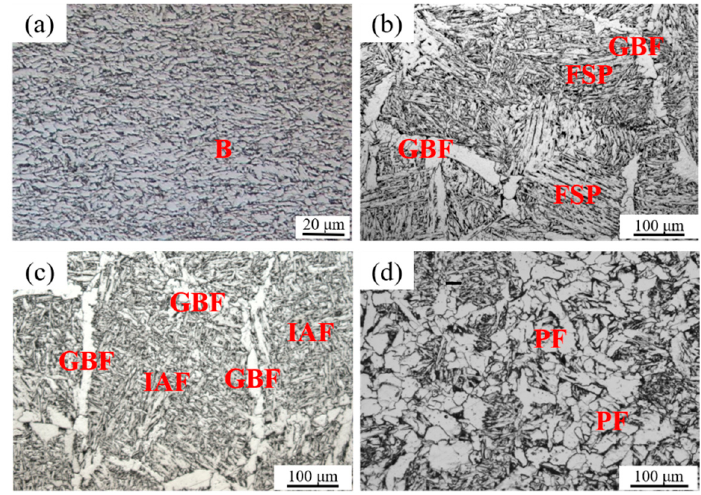
Figure 2. Microstructures of base metal ( a ) and HAZs after simulated high-heat-input welding of 400 kJ / cm for ( b ) Al deoxidation (A), ( c ) low-content Mg deoxidation (LM), and ( d ) high-content Mg deoxidation (HM).